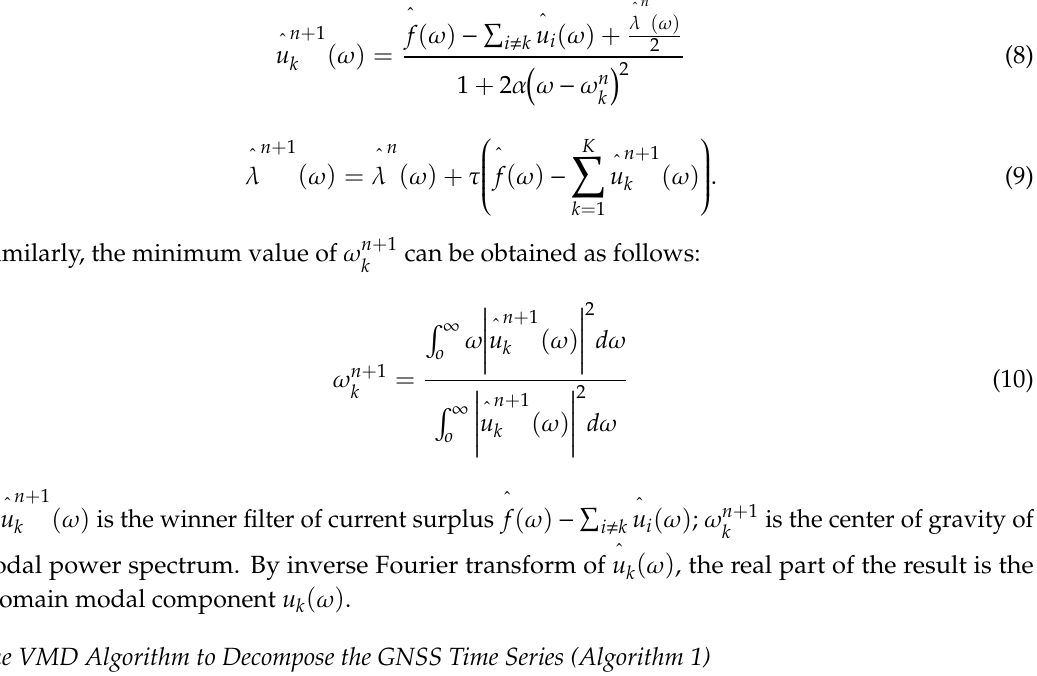
Algorithm 1: The VMD algorithm to decompose the GNSS time